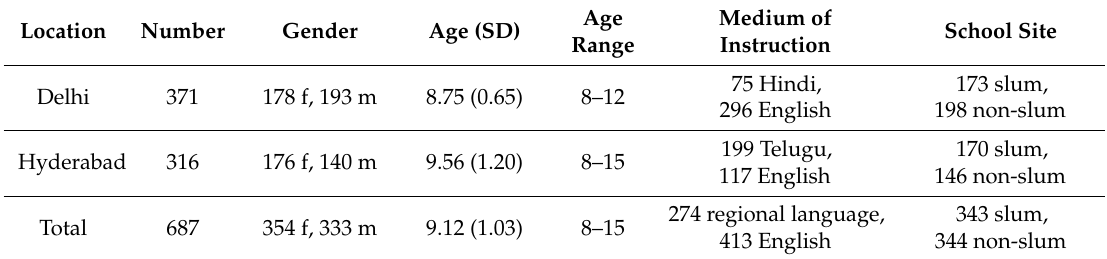
Table 1. Overview of the demographic